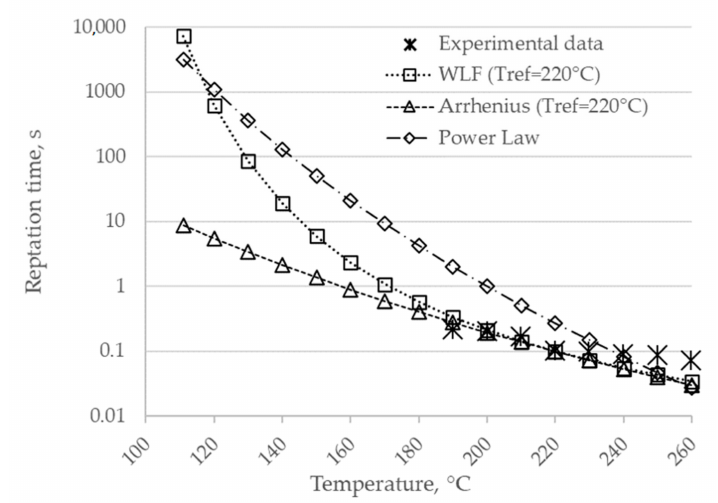
Figure 6. Comparison of the three models used for the extrapolation of t rep between the melting and the crystallization temperature.